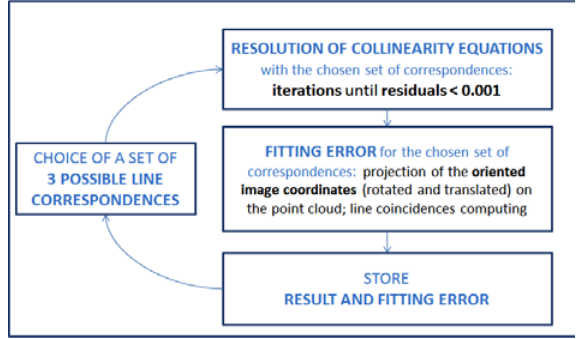
Figure 11. Iterative processes used for the resolution of the collinearity equations and the image registration with the point cloud.